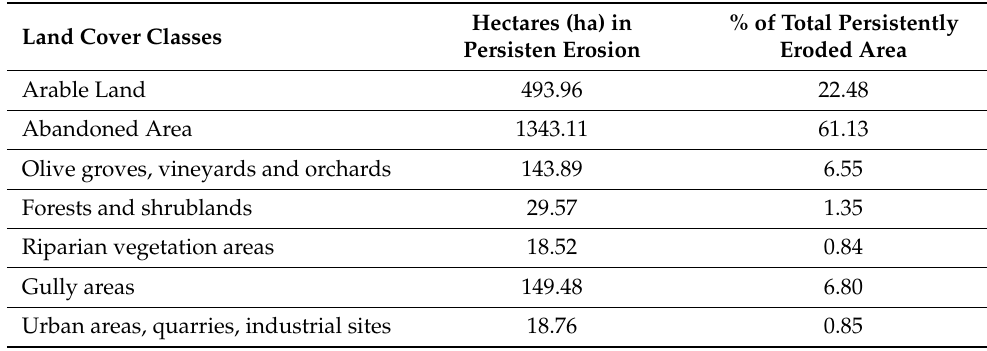
Table 3. Surfaces in hectares and as a percentage of areas in permanent erosion. Land Cover